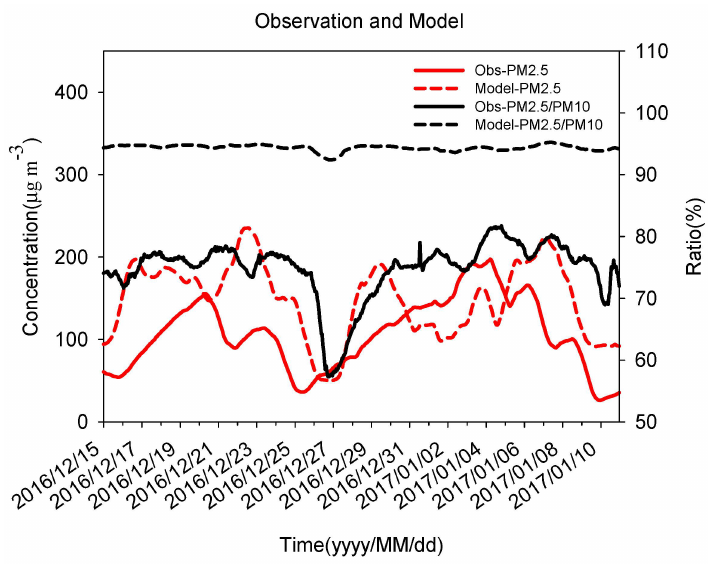
Figure 4. Time series of simulated and observed hourly mean PM 2.5 concentrations ( µ g m − 3 ) and ration of PM 2.5 in PM10 (unit:%) of the five cities in Southern Sichuan from 15 December 2016 to 11 January 2017. The solid black line is for Obs-PM 2.5 , the dash black line is for the ratio of observed PM 2.5 in PM10. The solid red line is for Model-PM 2.5 , the dash red line is for the ratio of simulated PM 2.5 in